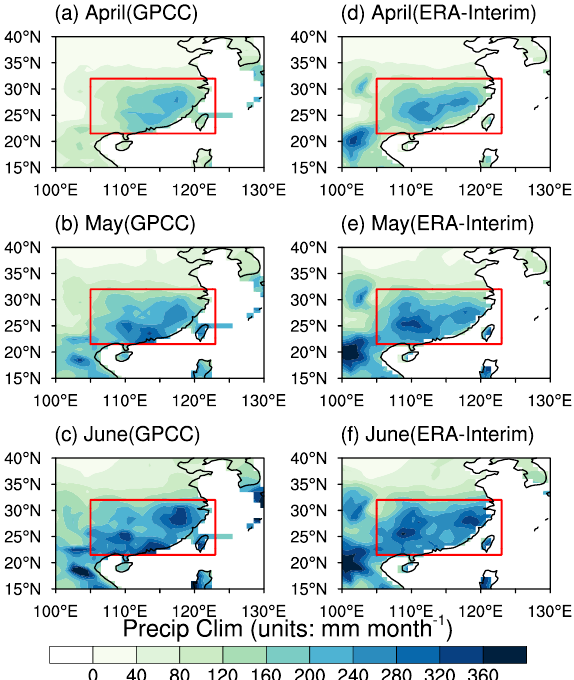
Figure 1. Climatological mean of April, May and June precipitation (units: mmmonth − 1 ) during 1979–2015: ( a ) April; ( b ) May; and ( c ) June based on GPCC; and ( d – f ) the same as ( a – c ) but based on ERA-Interim. South China is defined as the continental areas within the red box (21.5–32 ◦ N, 105–123 ◦ E).